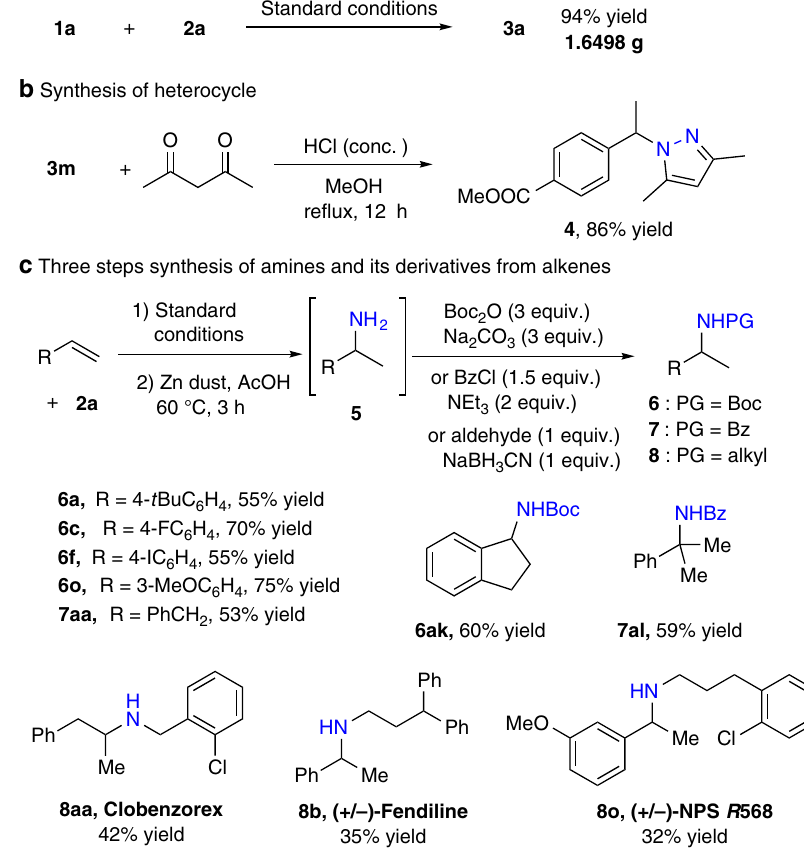
Fig. 3 Synthetic applications. a Gram-scale synthesis. b Heterocycle synthesis. c Three steps synthesis of amines and its